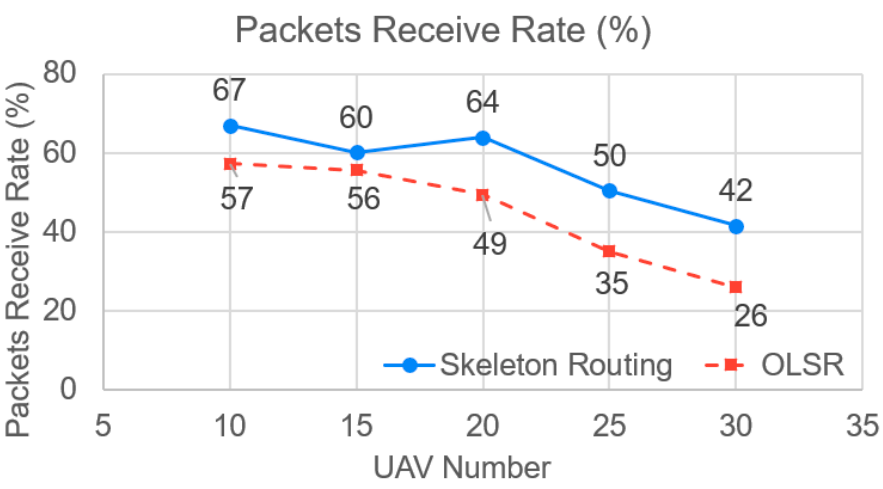
Figure 20. Packets reception rate results with varying network sizes.